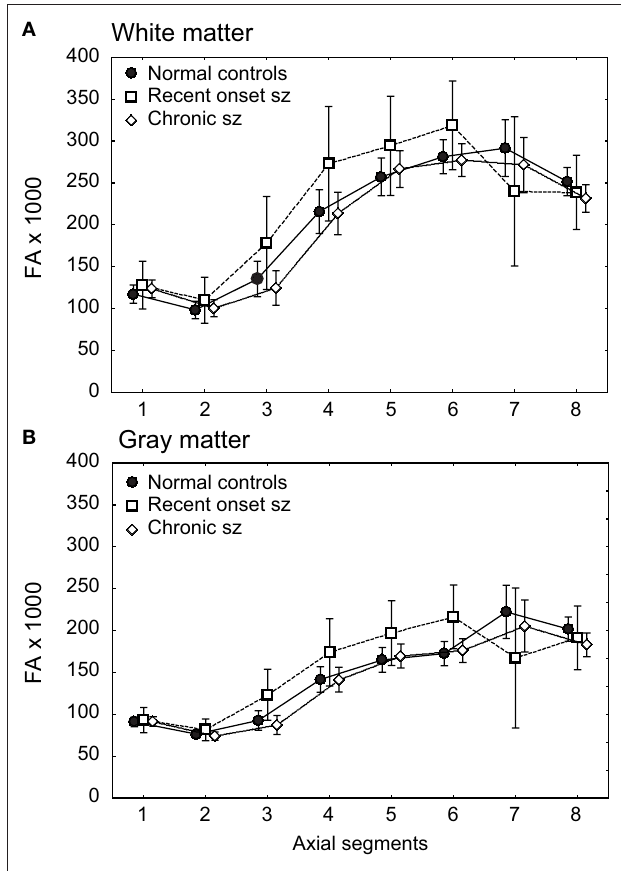
FIGURE 1 | Human DTI along rostrocaudal axial segments of the entire cingulate gyrus, spanning from area 32 (segment 1) to area 23 (segment 8). (A) FA values showing a signifi cant region × diagnosis effect in the cingulate white matter, with patients with recent-onset schizophrenia displaying the highest FA in most segments, followed by control subjects and then patients with chronic schizophrenia (ANCOVA F = 2.42, p = 0.003). 14,567 (B) The same pattern was noted in cingulate grey matter, also with a signifi cant region × diagnosis effect (ANCOVA F = 3.01, p < 0.001). Vertical 14,567 bars indicate 95% confi dence intervals and values are computed for the age covariate at its mean. Normal controls ( n = 38), recent-onset schizophrenia ( n = 6), chronic schizophrenia ( n = 41); sz, schizophrenia; FA, fractional